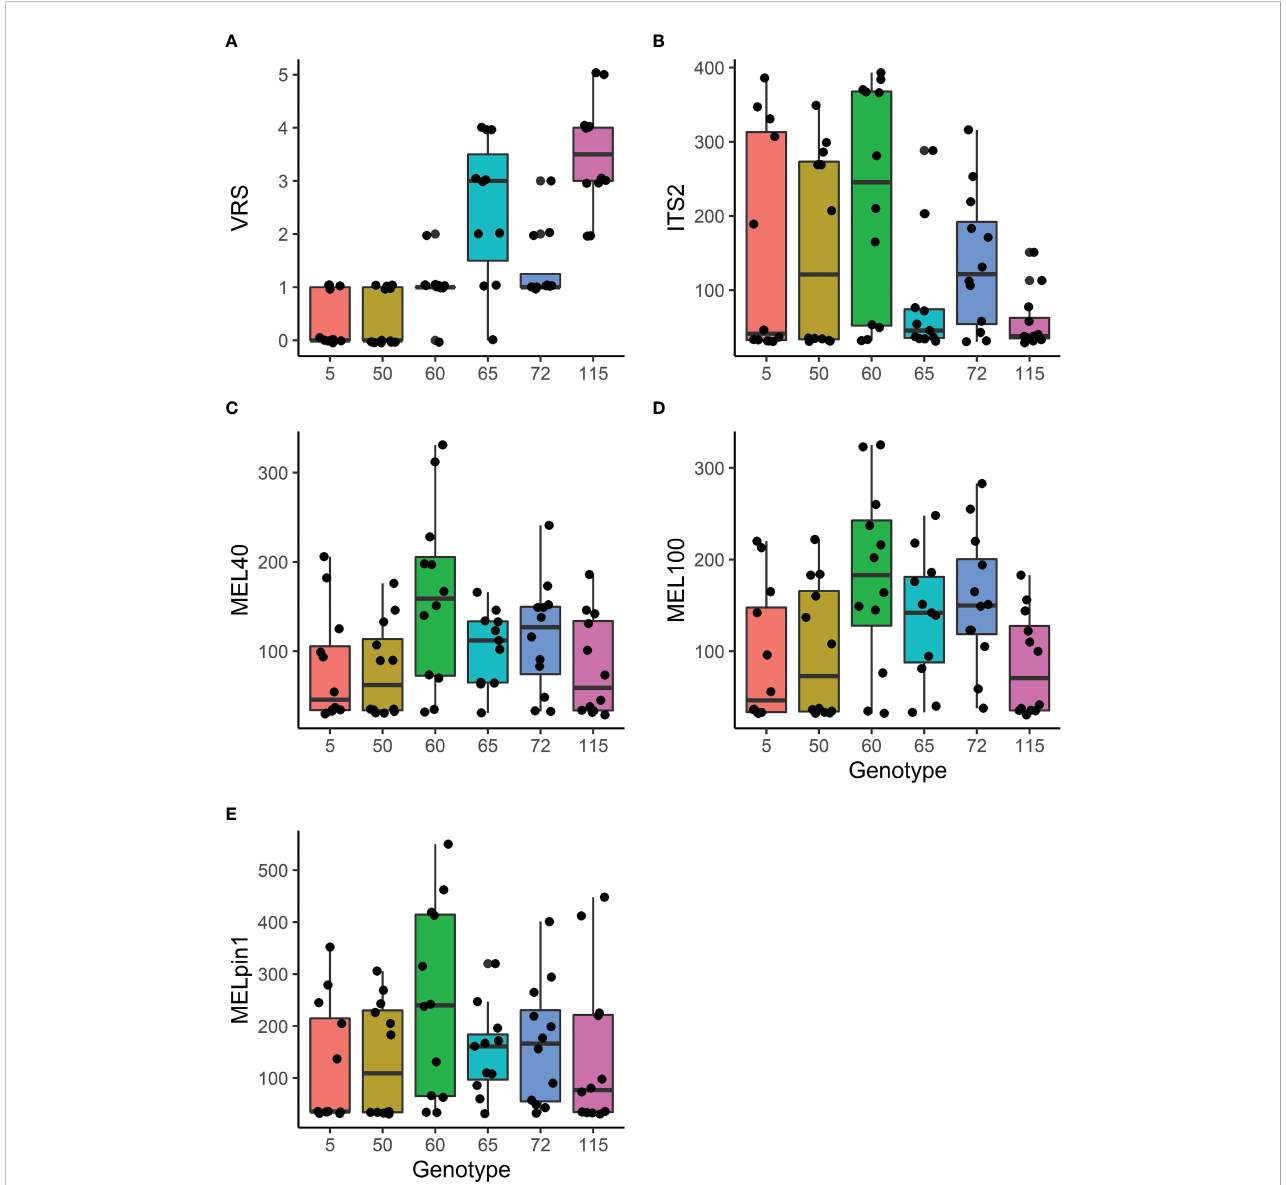
FIGURE 3 The effect of genotype on foliar rust related responses: (A) Visual rust score (VRS; for details, see Figure 1). (B) PCR concentration (ng/ml) of molecular markers of general fungal presence (ITS2 region of fungal rDNA ampli fi ed using ITS3f+ITS4r); (C, D) Fungal DNA originating from the Melampsora genus (MEL40 and MEL100); and (E) Fungal DNA from the native rust M. pinitorqua (MELpin1) (see also Table 1). Test summaries are given in Table 3. The upper and lower boundaries of the boxes correspond to the 25 th and 75 th percentile values, respectively, and the horizontal lines inside the boxes indicate the median value for the relevant genotype. Vertical lines represent the range of values observed per tested unit based on 11 or 12 replicates per genotype and the black dots are the representation of individual